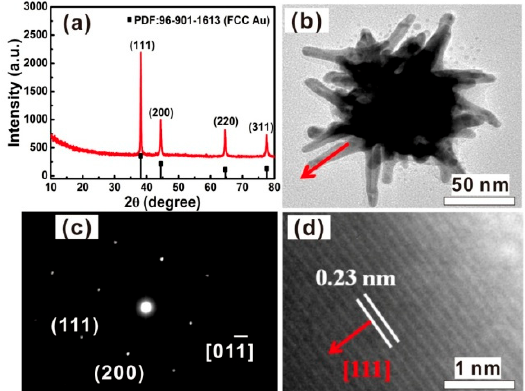
Figure 3. ( a ) XRD pattern of the chestnut-like Au nanocrystals. The line spectrum is the standard pattern of Au powders. ( b ) TEM image of an individual chestnut-like Au nanocrystal. ( c ) Selected area electron diffraction (SAED) pattern of the particle in ( b ). ( d ) HRTEM image of the nanoneedle marked with an arrow in ( b ). The arrows in ( b , d ) are parallel.